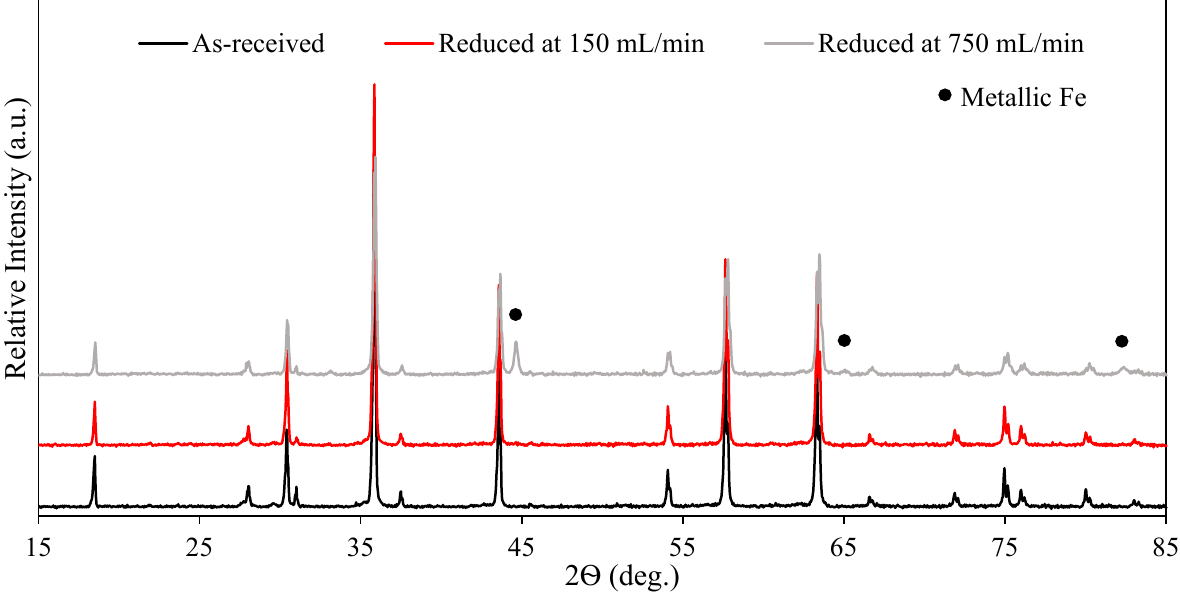
Figure 3. XRD patterns of the as-received chromite ore, and samples reduced at 150 and 750 mL/min hydrogen flow rates at 1100 °C for 60 min.